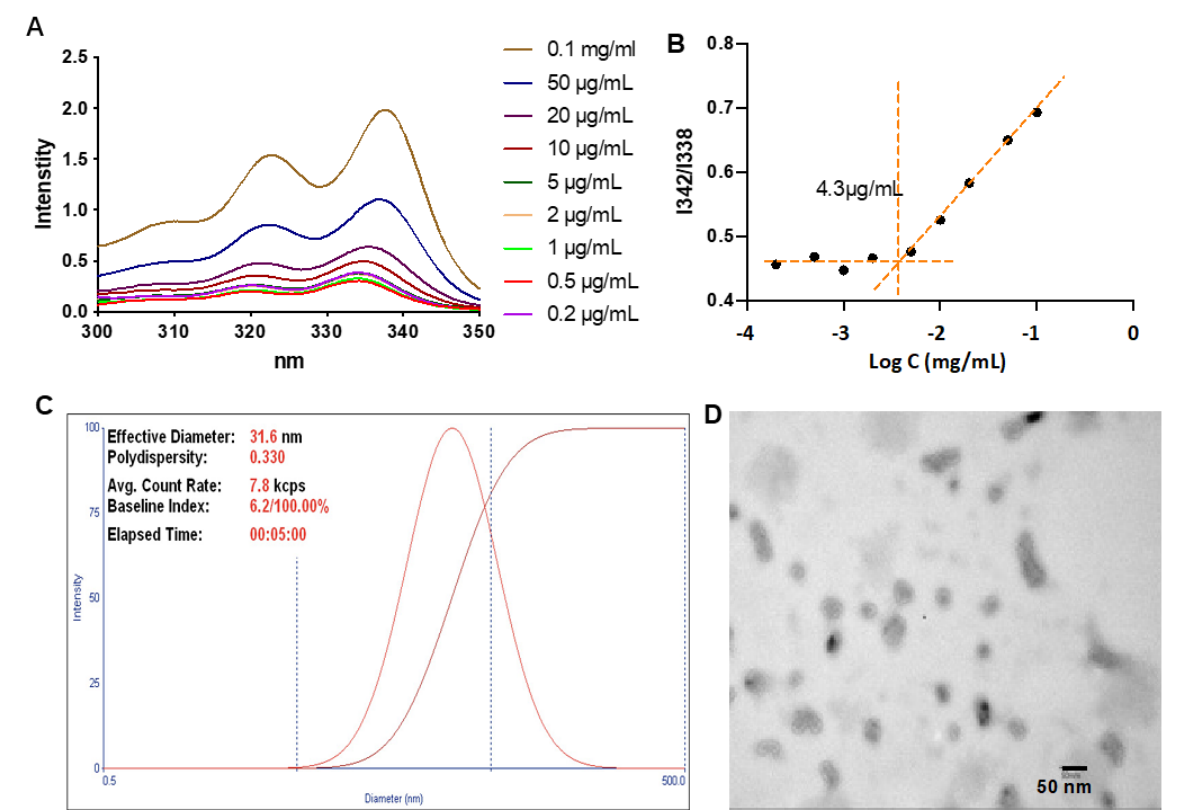
Figure 3. ( A ) Determine the CMC of TPGS-L-NETA-Gd; ( B ) the value of CMC was 4.3 µ g/mL; ( C ) DLS data of TLNm in water; ( D ) TEM bright-field image of TLNm dried on formvar-coated copper grids (scale bar = 50